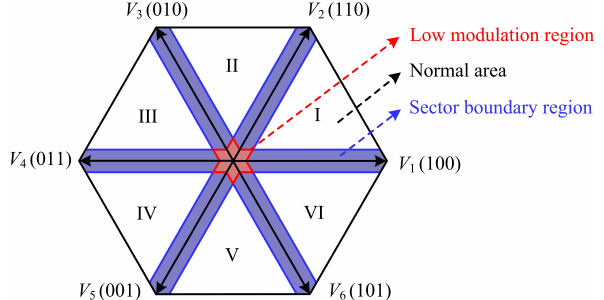
Figure 2. The normal working area and current reconstruction dead zones using the single DC-link current sensor